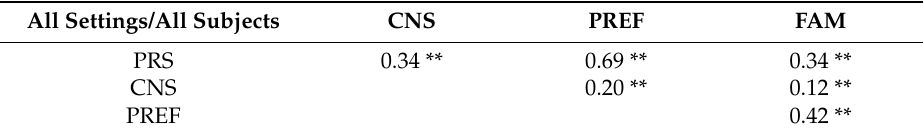
Table 4. Pearson’s correlations between the connectedness to Nature scale (CNS), the perceived restorativeness scale (PRS), preference (PREF), and familiarity (FAM) scores for all subjects/settings. All Settings/All Subjects CNS PREF FAM PRS 0.34 ** 0.69 ** 0.34 ** CNS 0.20 ** 0.12 ** PREF 0.42 ** ** Correlation is significant at the 0.01 level (two-tailed).